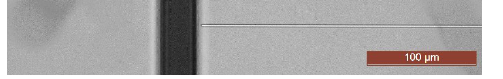
Fig. 1. Top-view of the optical waveguide orthogonally aligned with the microfluidic channel.